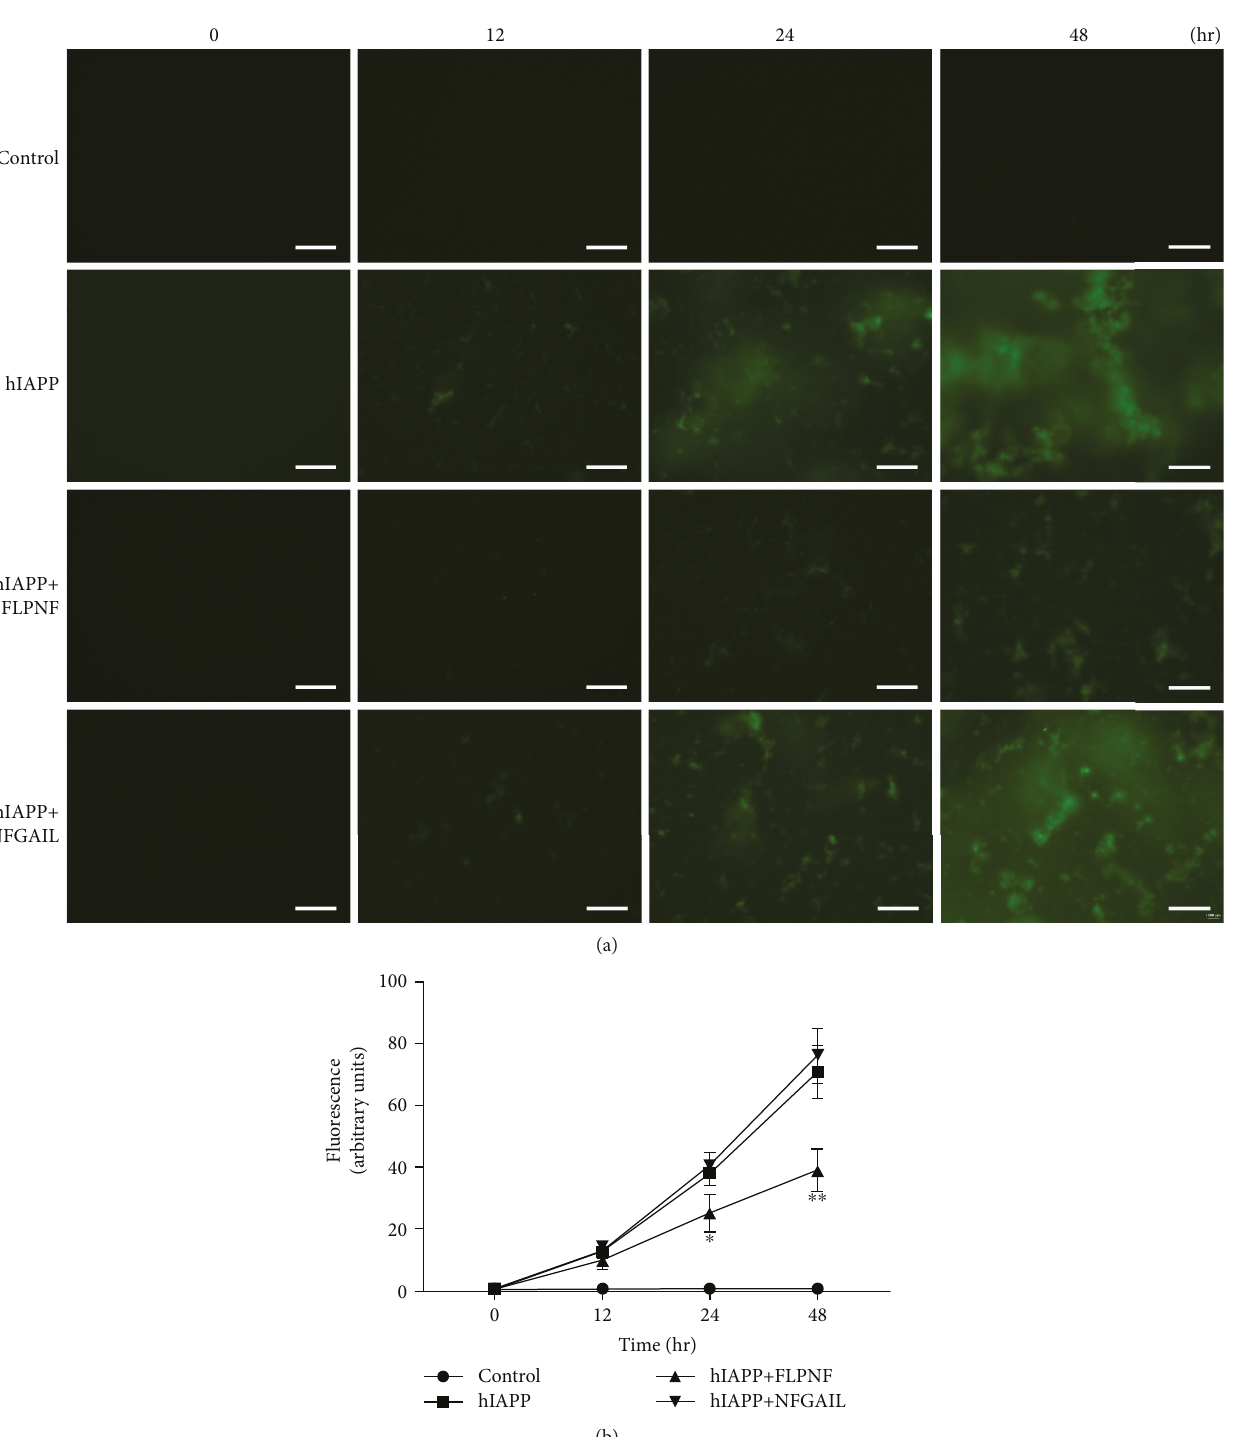
Figure 2: Quantitative analysis of the inhibitory e ff ects of FLPNF and NFGAIL on hIAPP aggregation formation by Thio fl avin T (ThT) staining. (a) ThT fl uorescence of each group was observed at 0, 12, 24, and 48 hours using a fl uorescence microscope ( “ control ” represented PBS solution, “ hIAPP ” represented 10 μ M hIAPP in PBS, “ hIAPP+FLPNF ” represented 10 μ M hIAPP with 100 μ M FLPNF in PBS, and “ hIAPP+NFGAIL ” represented 10 μ M hIAPP with 100 μ M NFGAIL in PBS; 20 μ M ThT was added to each group; scale bar: 50 μ m). (b) ThT fl uorescence intensity values were measured by a luminescence meter at 0, 12, 24, and 48 hours (values were presented as means ± SD ; each experiment was repeated thrice; ∗ signi fi cantly di ff erent compared to hIAPP, unpaired t -test, P < 0 05 ; ∗∗ signi fi cantly di ff erent compared to hIAPP, unpaired t -test, P < 0 01